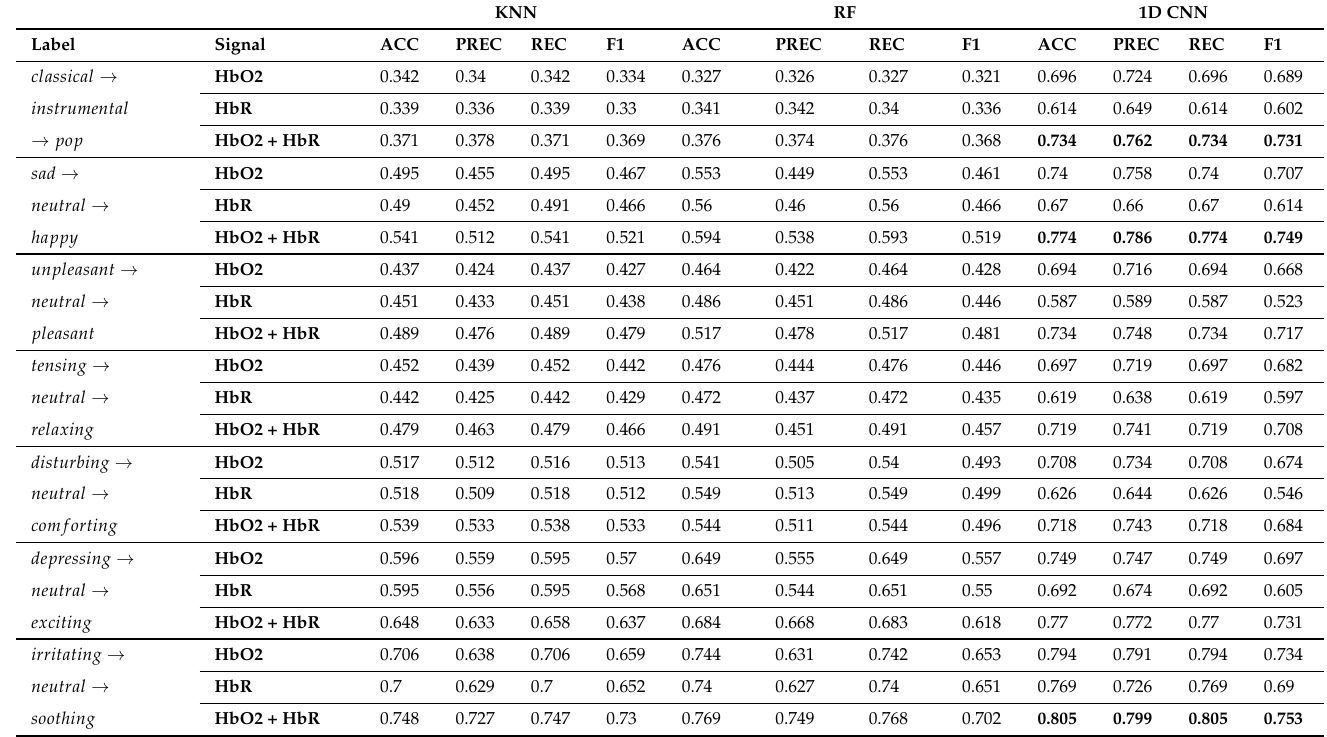
Table 3. Evaluation Measure Results Using KNN, RF and 1D